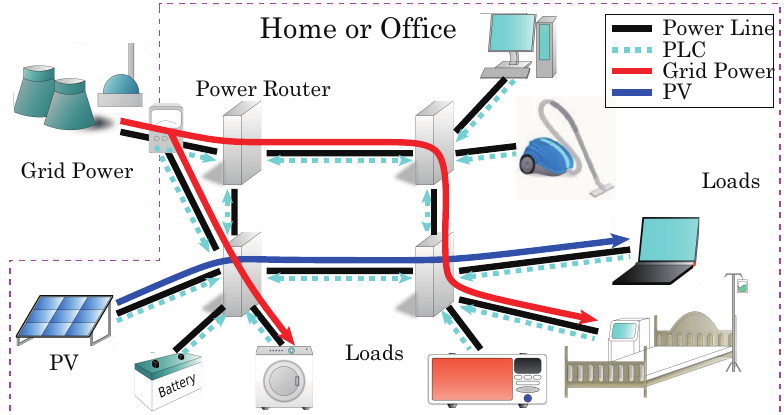
Figure 1. Configuration of an AC power routing system. PLC: power line communication.